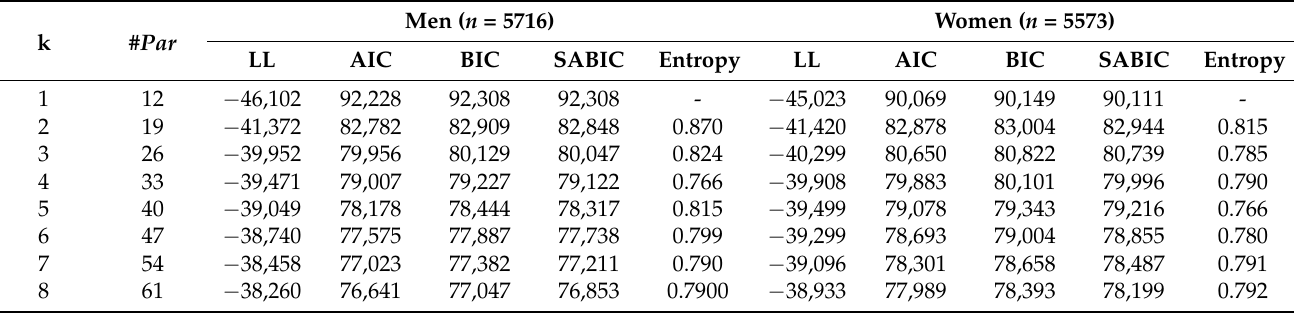
Table 2. Fit Indices of the LPA Solution for Each Gender